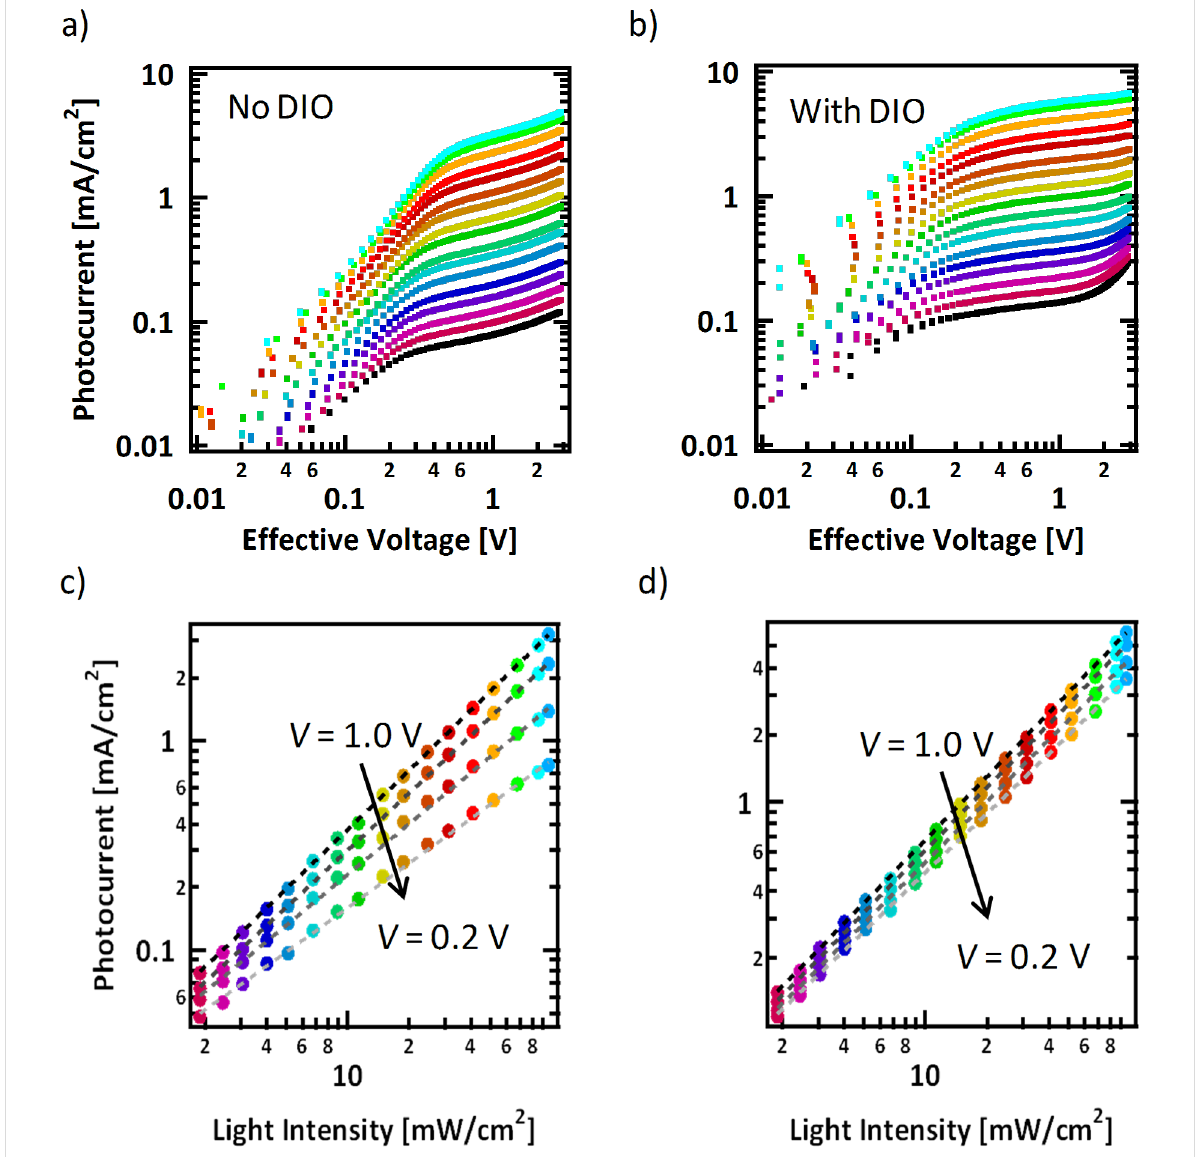
Figure 3: Light intensity dependence of photocurrent as a function of the effective voltage, V 0 − V, for devices cast a) without DIO and b) with DIO and the extracted photocurrent at effective voltages of 1.0, 0.5, 0.3, and 0.2 V (from black to grey, respectively) as detailed in Table 2 for devices cast c) without DIO and d) with